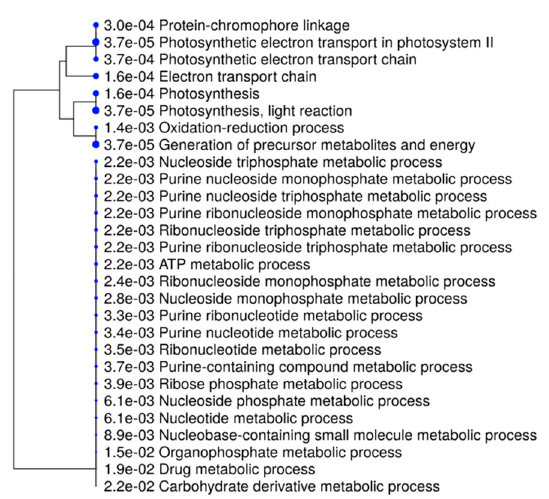
Figure 7. A hierarchical clustering tree. Pathways with many shared genes are clustered together. Larger dots indicate the more highly significant p -values.